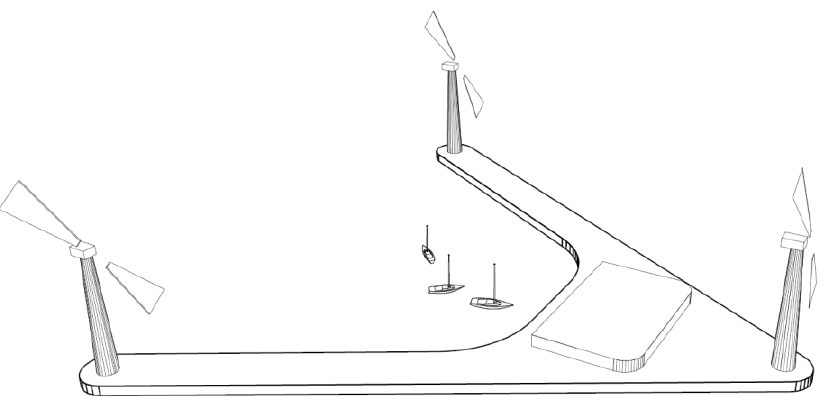
Figure 1. Application example of the Delta very large floating structure (VLFS).